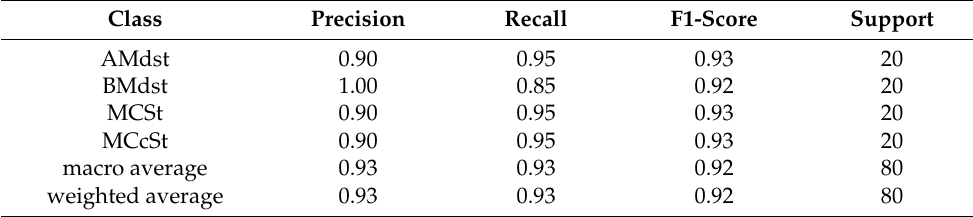
Table A6. Classification report for ResNet18 pretrained on HAM10000. The overall accuracy is 0.93.